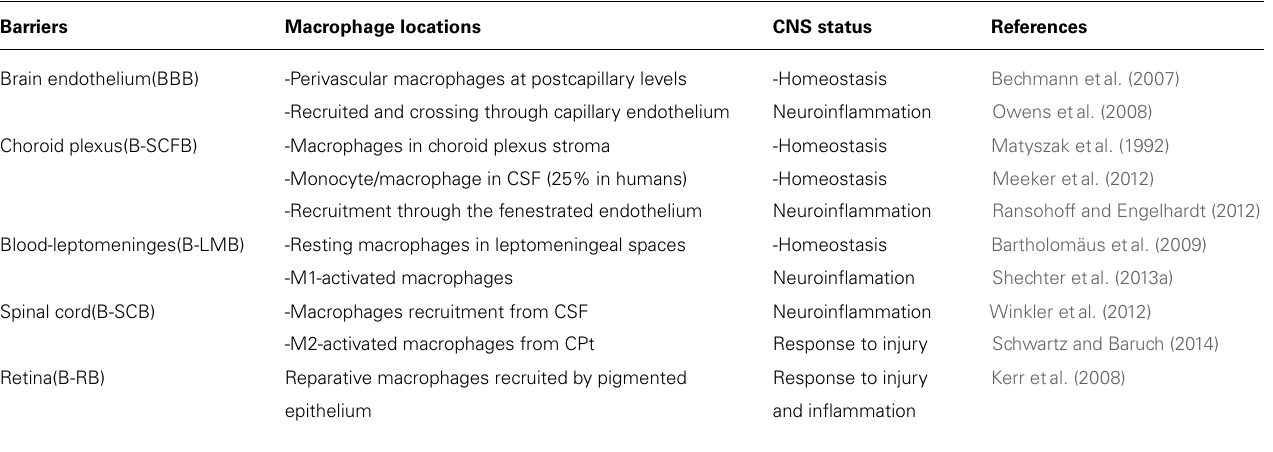
Table 1 | Monocyte recruitment through intacts brain